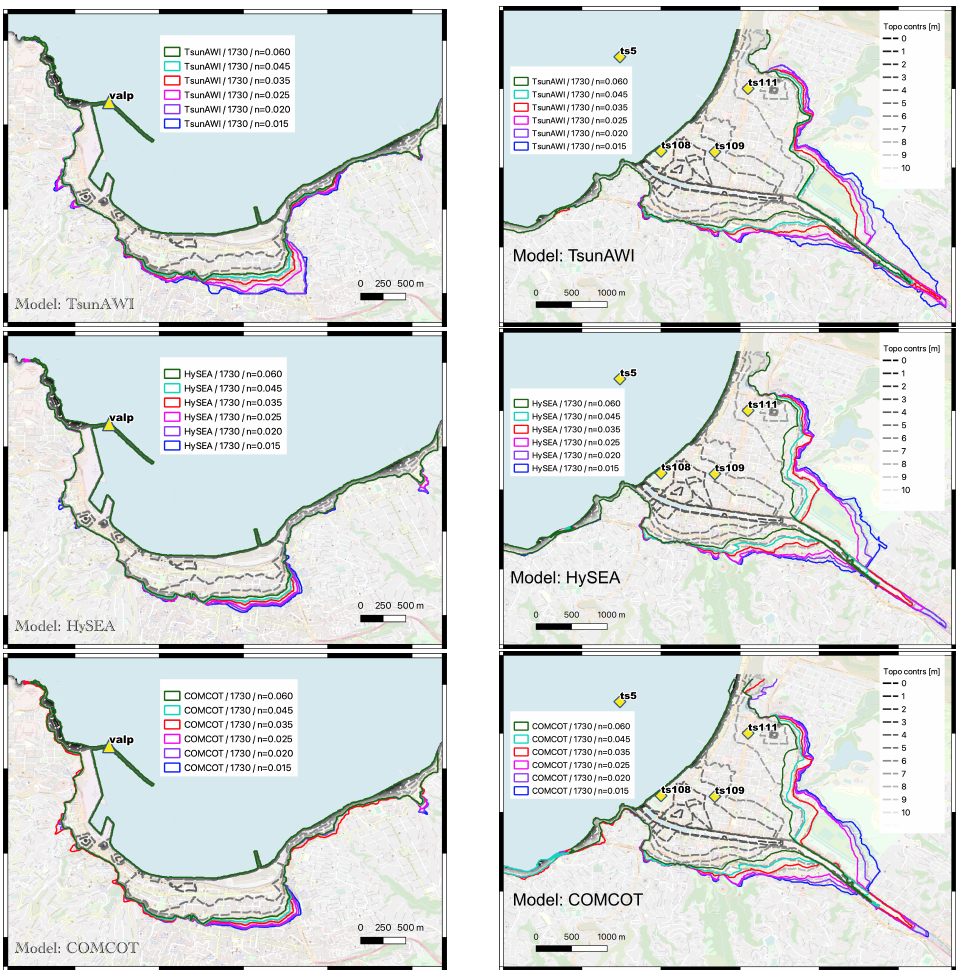
Figure 11. Extent of inundation areas obtained by the three numerical models for all Manning values tested in Experiment 1730 in Valparaíso ( left panels ) and Viña del Mar ( right panels ). Yellow diamonds show the virtual tide (valp) and inland gauges. Basemap: © OpenStreetMap